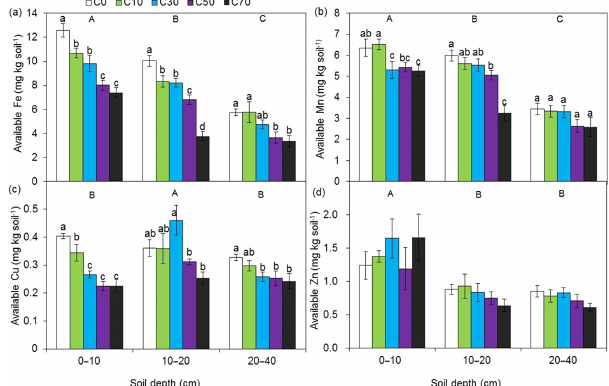
– – Values are R statistics for significant ( P <0.05) linear regressions. Multiple is R values for multiple regressions (stepwise removal) of soil base cation and micronutrients with soil pH, <0.25mm fine particles, and SOC. ∗ Indicates variables that make significant contributions to the multiple linear